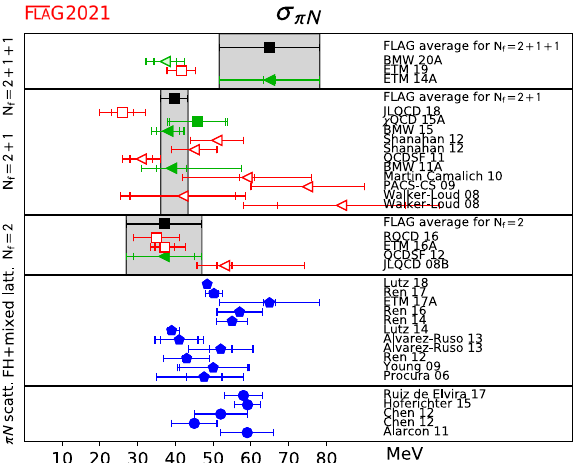
Fig. 47 Lattice results and FLAG averages for the nucleon sigma term, σ π N , for the N f = 2, 2 + 1, and 2 + 1 + 1 flavour calculations. Determinations via the direct approach are indicated by squares and the Feynman–Hellmann method by triangles. Results from calculations which analyze more than one lattice data set within the Feynman–Hellmann approach [1015,1021–1029] are shown for comparison (pentagons) along with those from recent analyses of π - N scattering [1003–1005,1030] (circles)